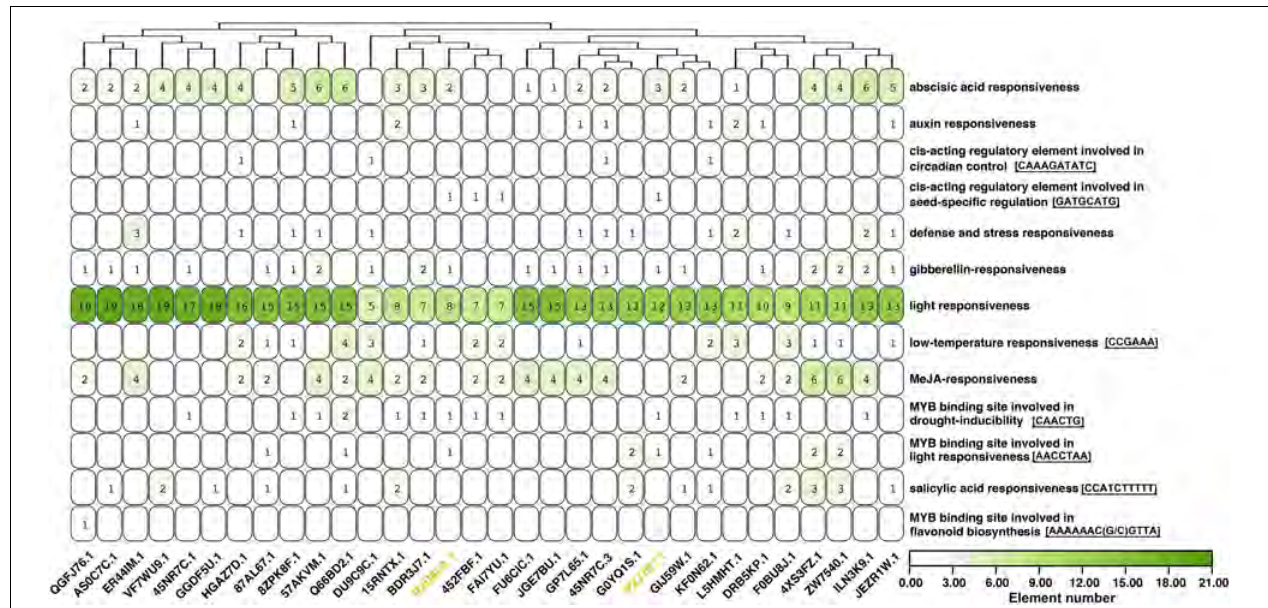
FIGURE 7 | Promoter analysis of 31 highly expressed AhAP2/ERF genes. Black gene ID: ERFs; yellow gene ID: RAV. Only elements with the same sequence were displayed. The number represents the number of conserved domains and those with zero number is not